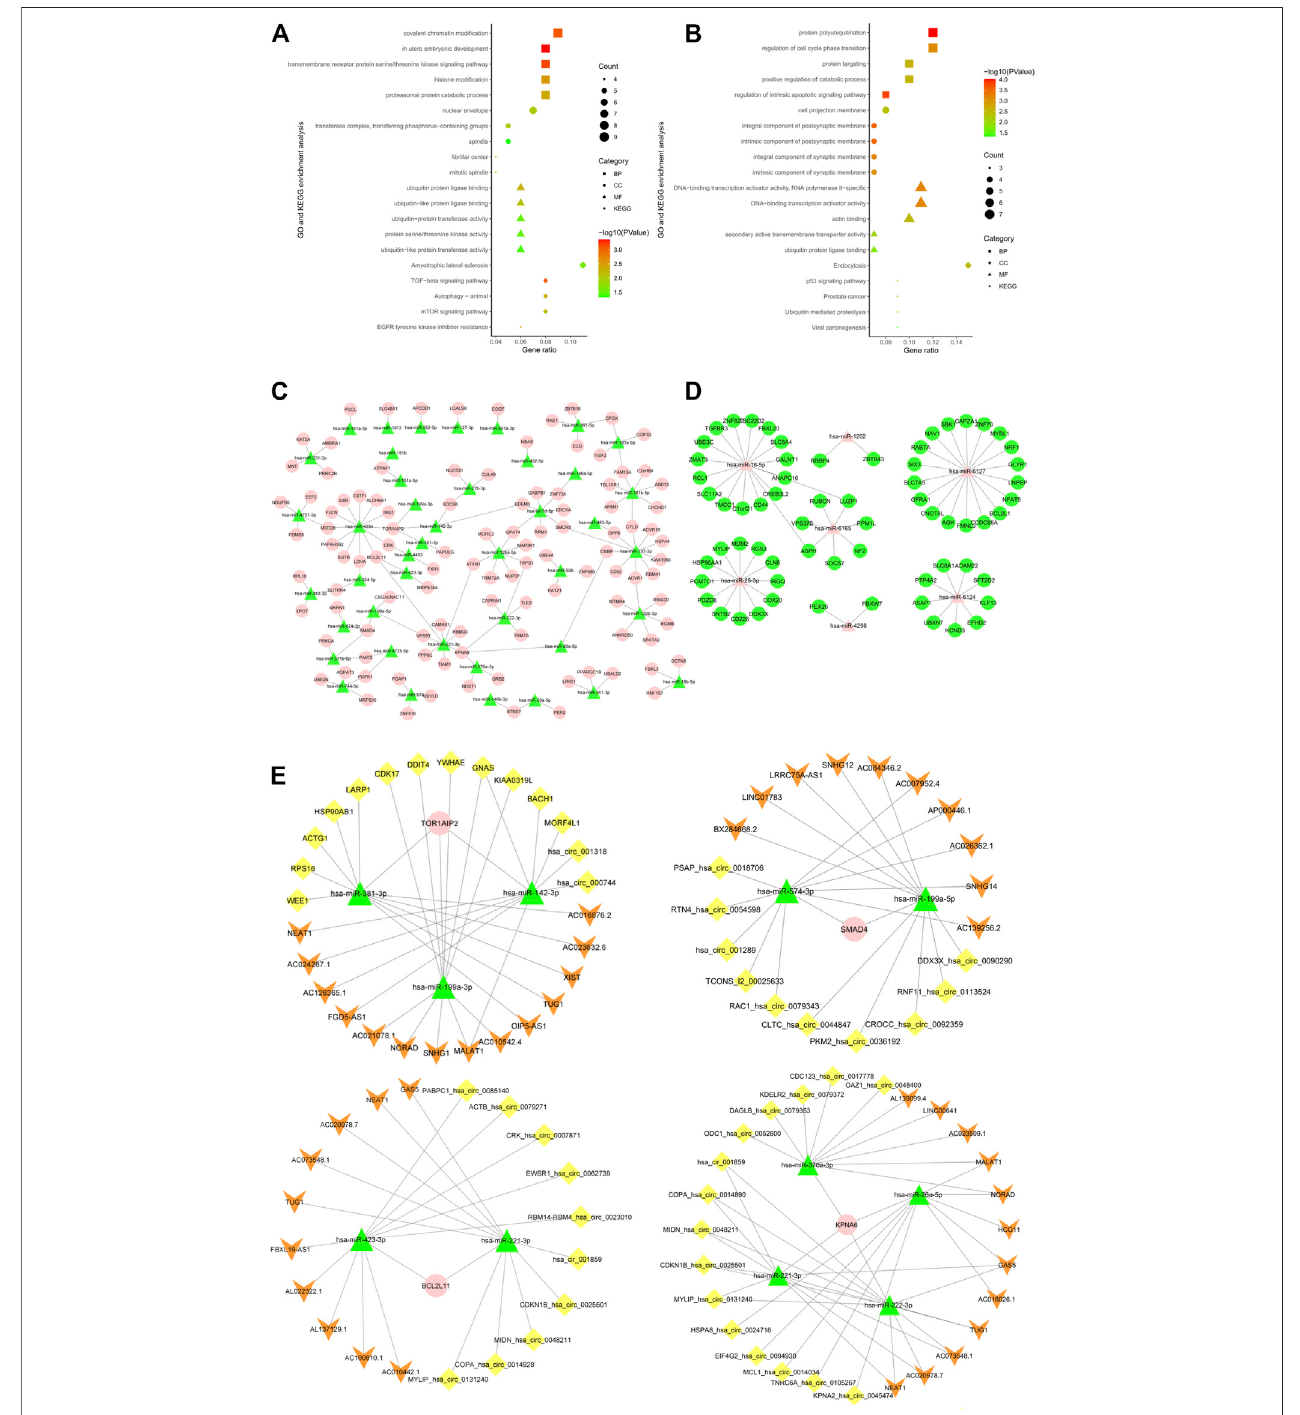
FIGURE 3 | The visualized regulatory network and enrichment bubble graph for miRNA-targeting DEGs. (A) , KEGG and GO enrichment bubble graph for overlapped up-regulated genes. (B) , KEGG and GO enrichment bubble graph for overlapped down-regulated genes. (C) , Regulatory network graph of 43 low- expression miRNAs. (D) , Regulatory network graph of seven high-expression miRNAs. (E) , ceRNA regulatory networks of TOR1AIP2, KPNA6, BCL2L11 and SMAD4.